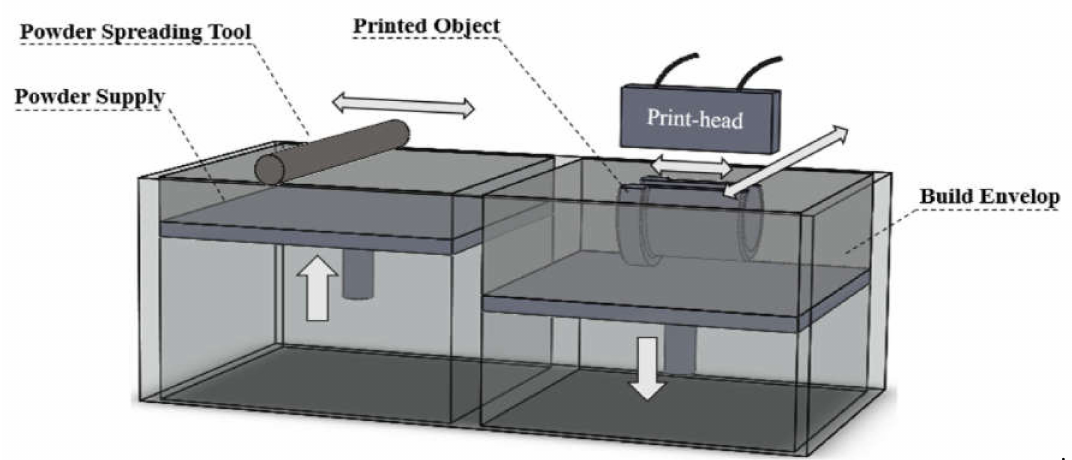
Figure 1. Schematic of the binder jetting system [30]; with permission from Elsevier.